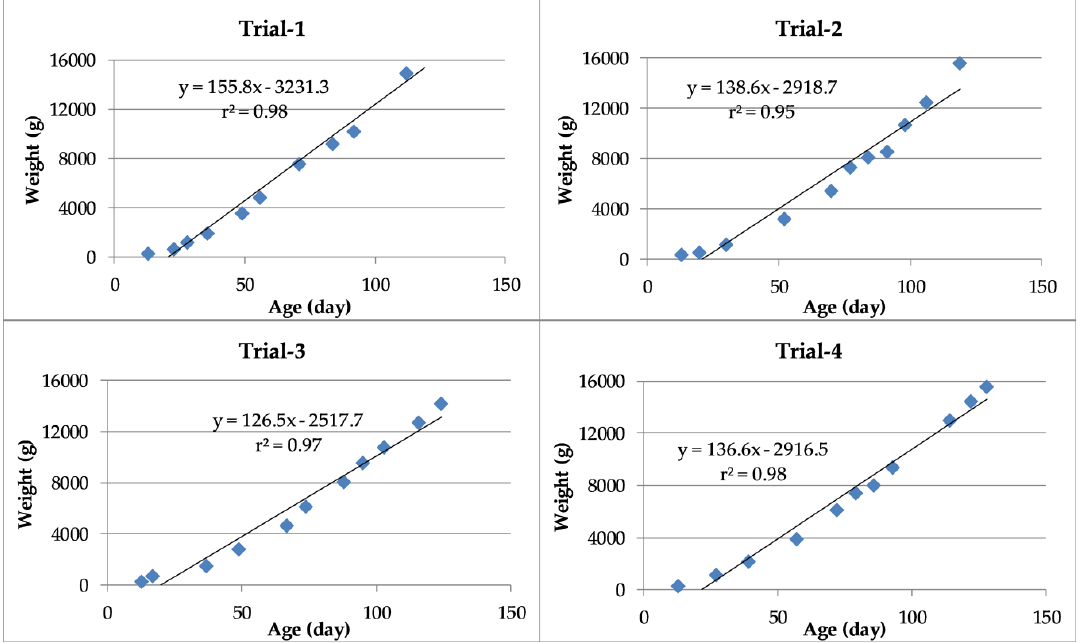
Figure 4. Linear regressions and coefficients of correlation between weight and age of turkeys.